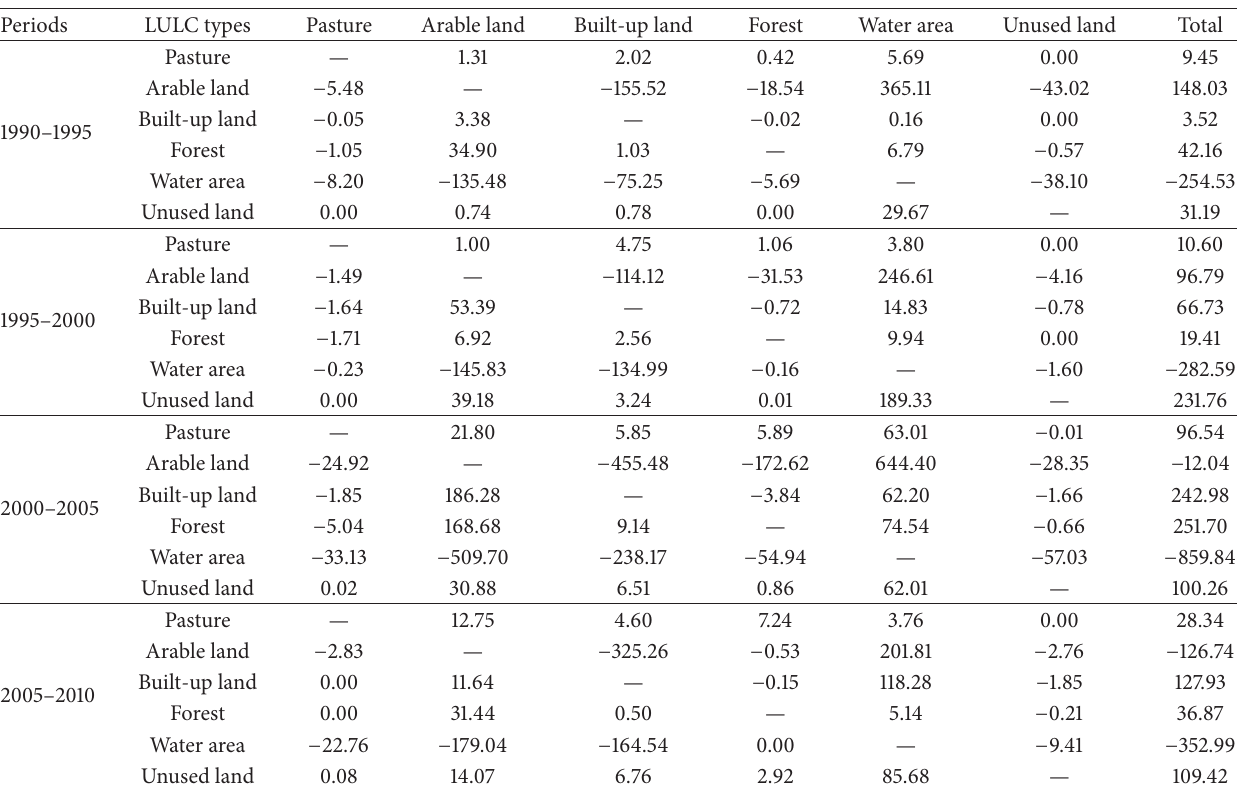
Table 4: The transfer matrix of ecological capacity from 1990 to 2010 in Wuhan city (unit: 10 2 ghm 2